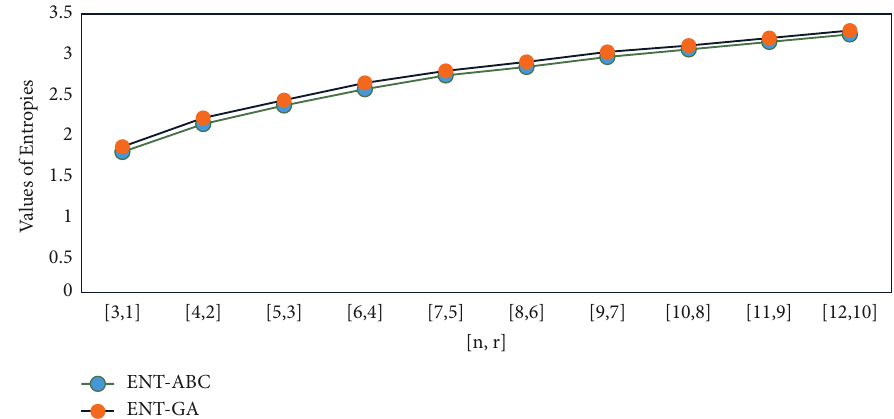
Figure 9: Comparison of Randic entropies for α � 1/2 and for α � − 1/2 for the coronoid system C